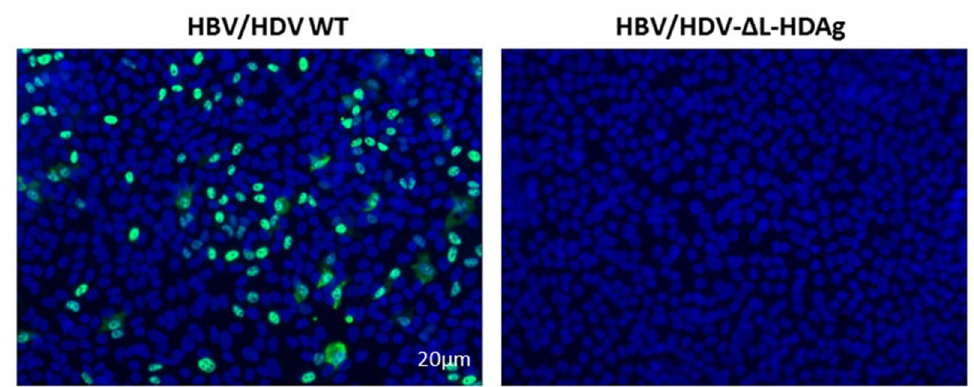
Figure 6. Infection of RagB6 mice with AAV-HBV/HDV- ∆ L-HDAg failed to produce HDV infectious particles. Huh-7-hNTCP cells were incubated with serum collected from AAV-HBV/HDV WT- and AAV-HBV/HDV- ∆ L-HDAg-infected RagB6 mice at 21-dpi. At 7-dpi, cells were fixed and immunostained to detect intracellular HDAg.